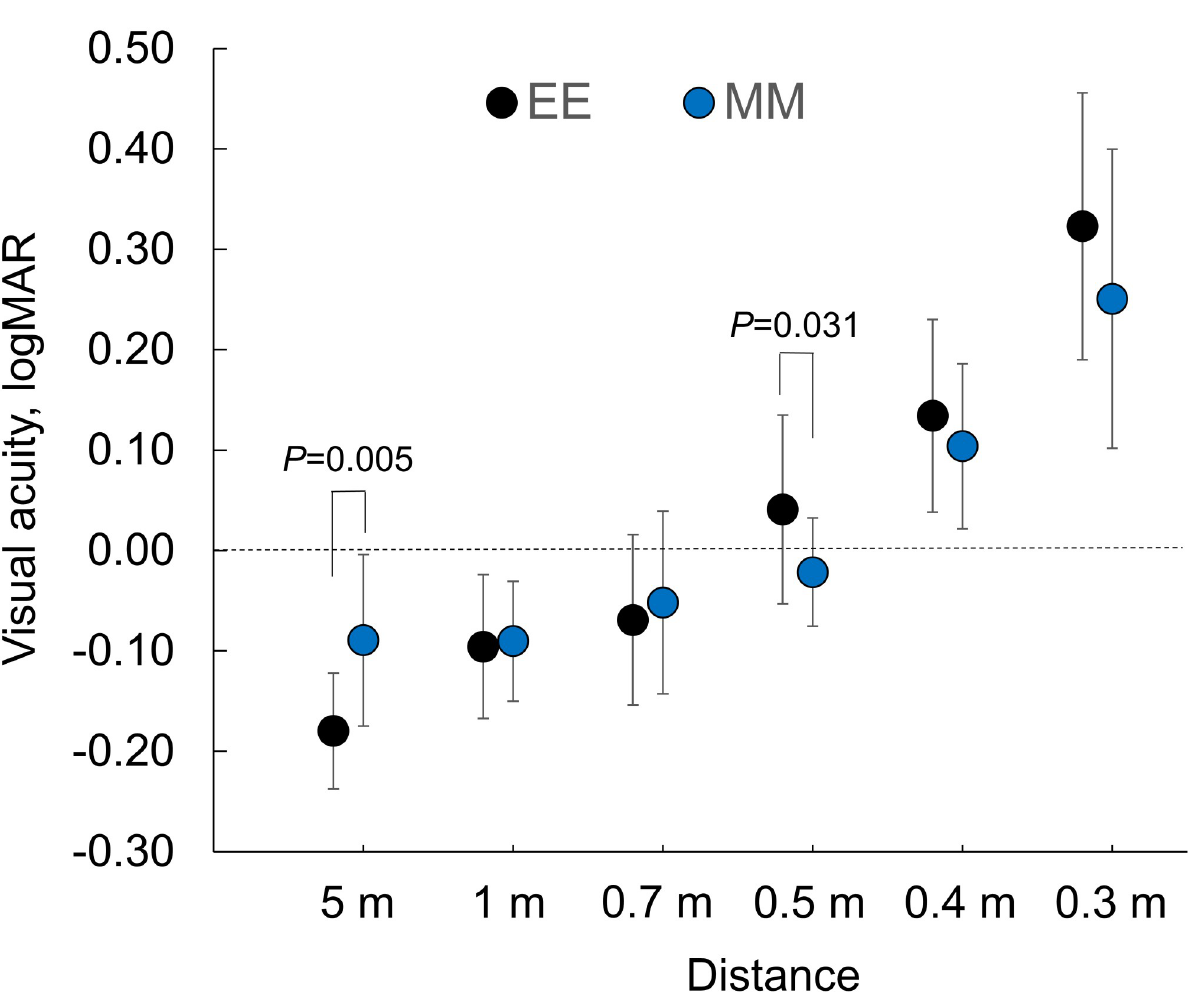
Fig 5. Binocular uncorrected visual acuities from 0.3 to 5.0 meter in the patients obtained the postoperative refractions in the ranges of -0.25 to +0.25 D (EE group) and -0.75 to -0.25 D (MM group) bilaterally. Significant differences were found at 5 m and 0.5 m (P = 0.005 and 0.031, the Mann-Whitney U-test). logMAR = logarithm of the minimum angle of resolution.